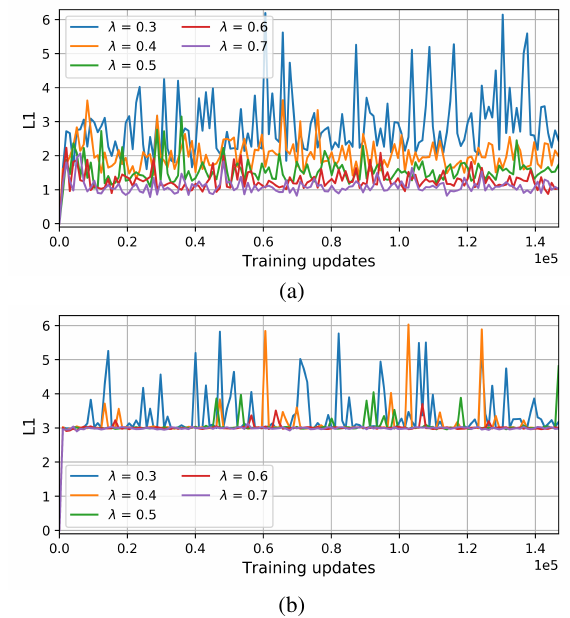
− θ (cid:107) over 140,000 iterations. (a) E S E T 1 with m = 3